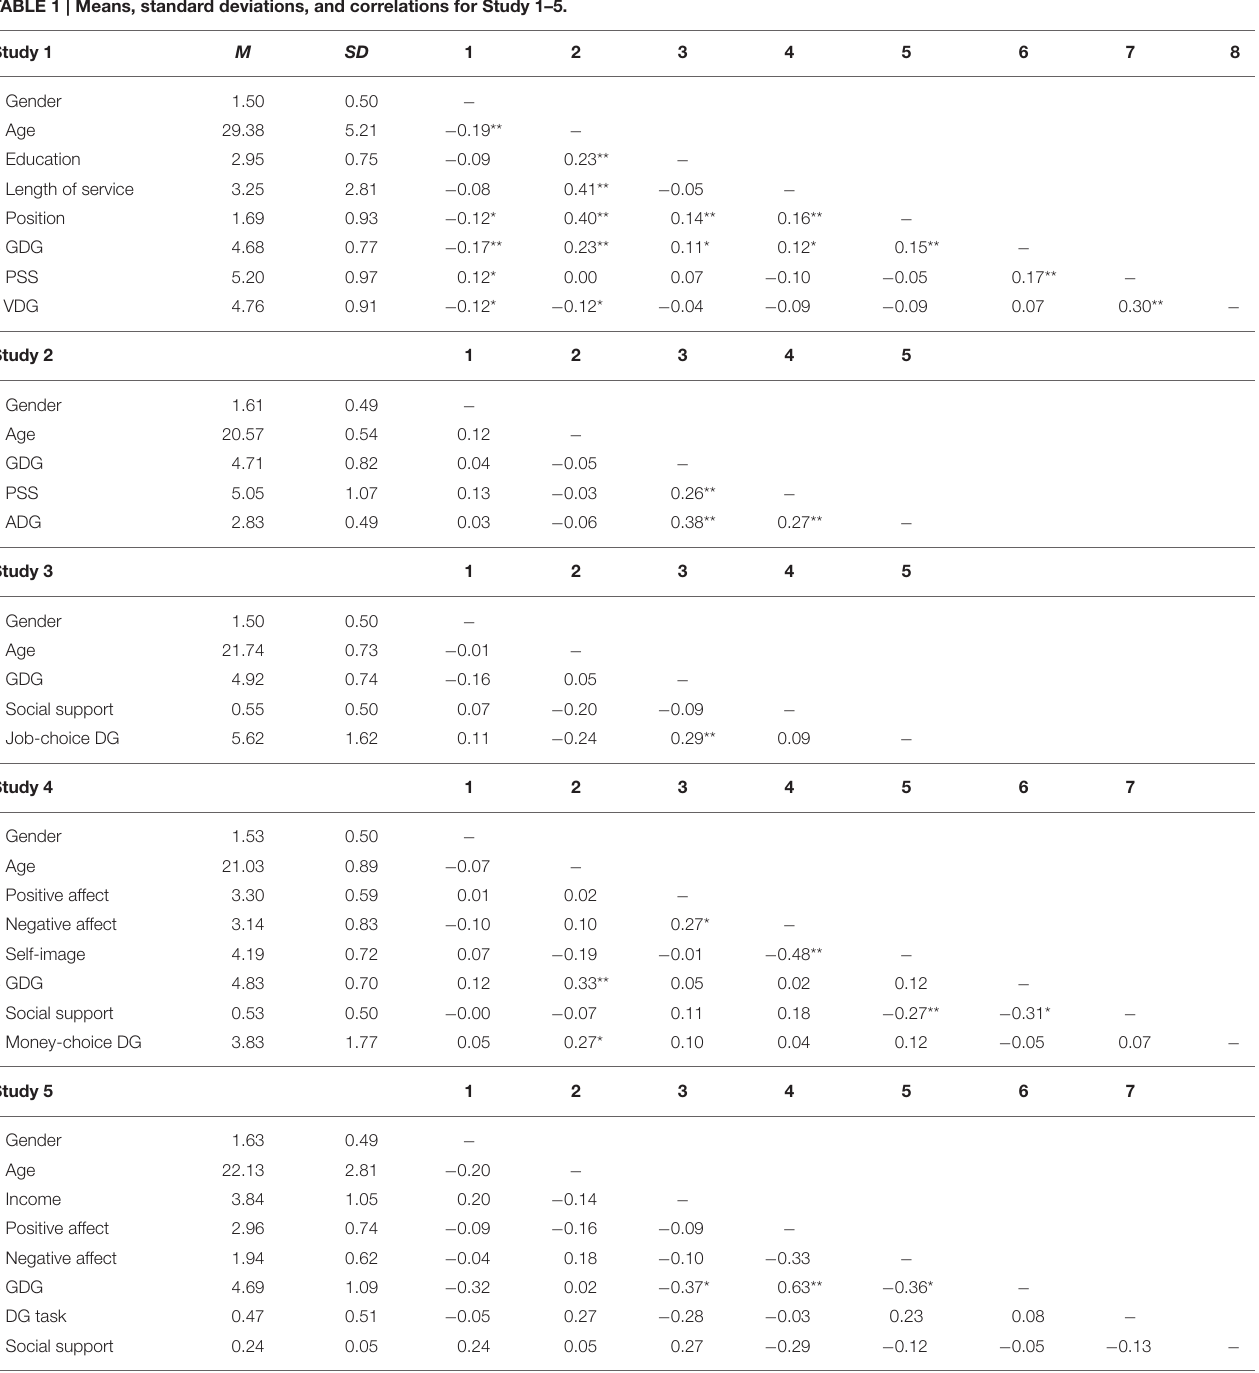
TABLE 1 | Means, standard deviations, and correlations for Study